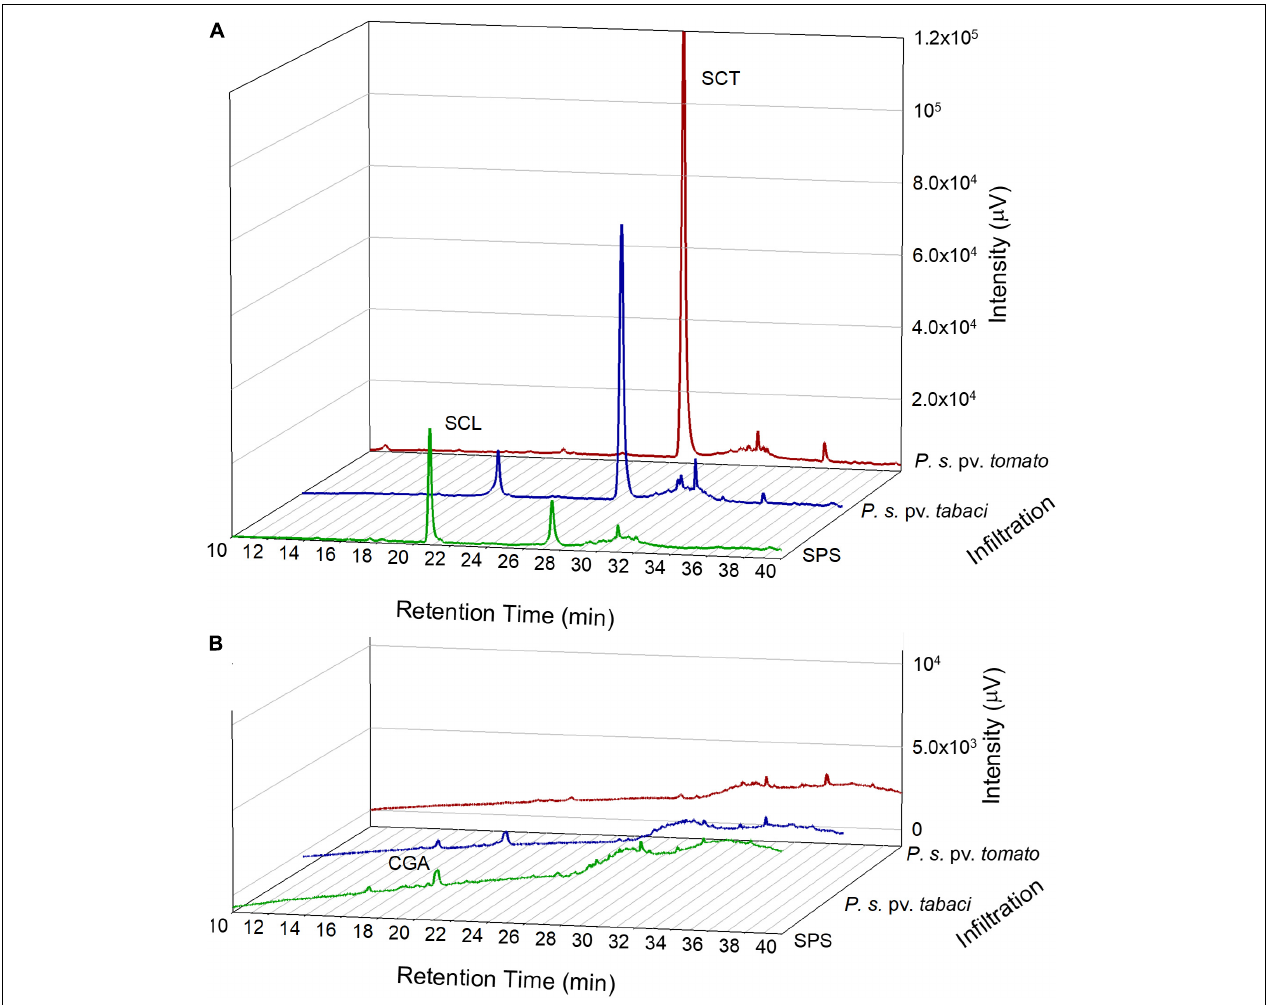
FIGURE 3 | Representative chromatograms from the HPLC analysis of tobacco leaf disk extracts acquired by a fluorescence detector, excitation at 340 nm and emission at 460 nm (A) and by a diode array detector at 330 nm (B) . Leaf samples were analyzed at 18 hpi with SPS, P. syringae pv. tabaci ATCC 11528 or P. syringae pv. tomato